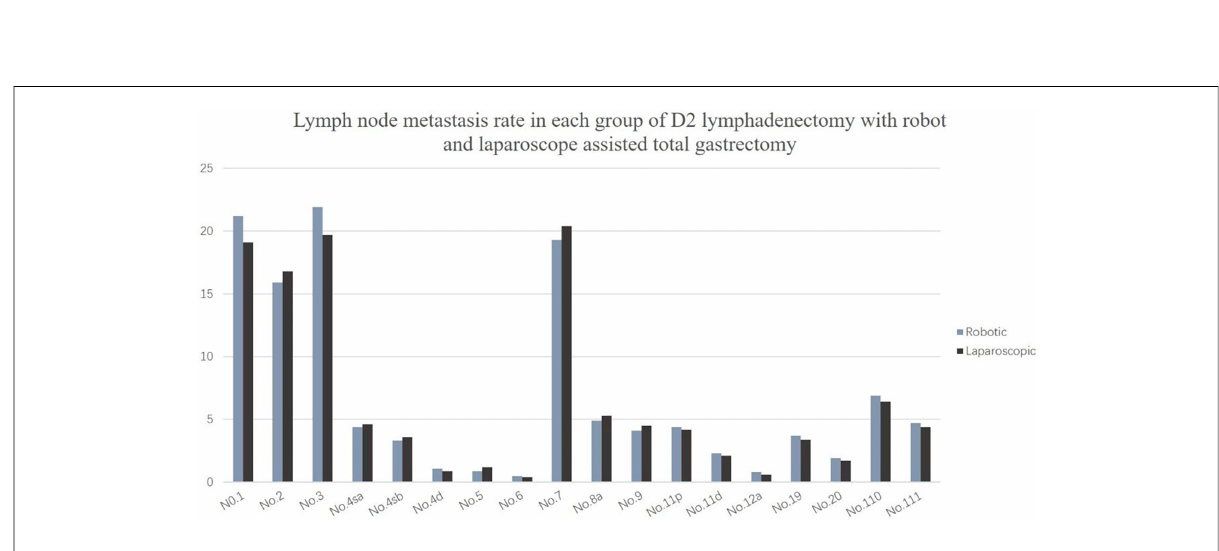
FIGURE 3 Lymph node metastasis rate in each group of D2 lymphadenectomy with robot and laparoscope assisted total gastrectomy.